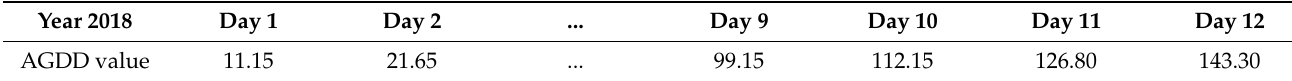
Table 4. AGDD calculated from daily 24-h temperatures of the year